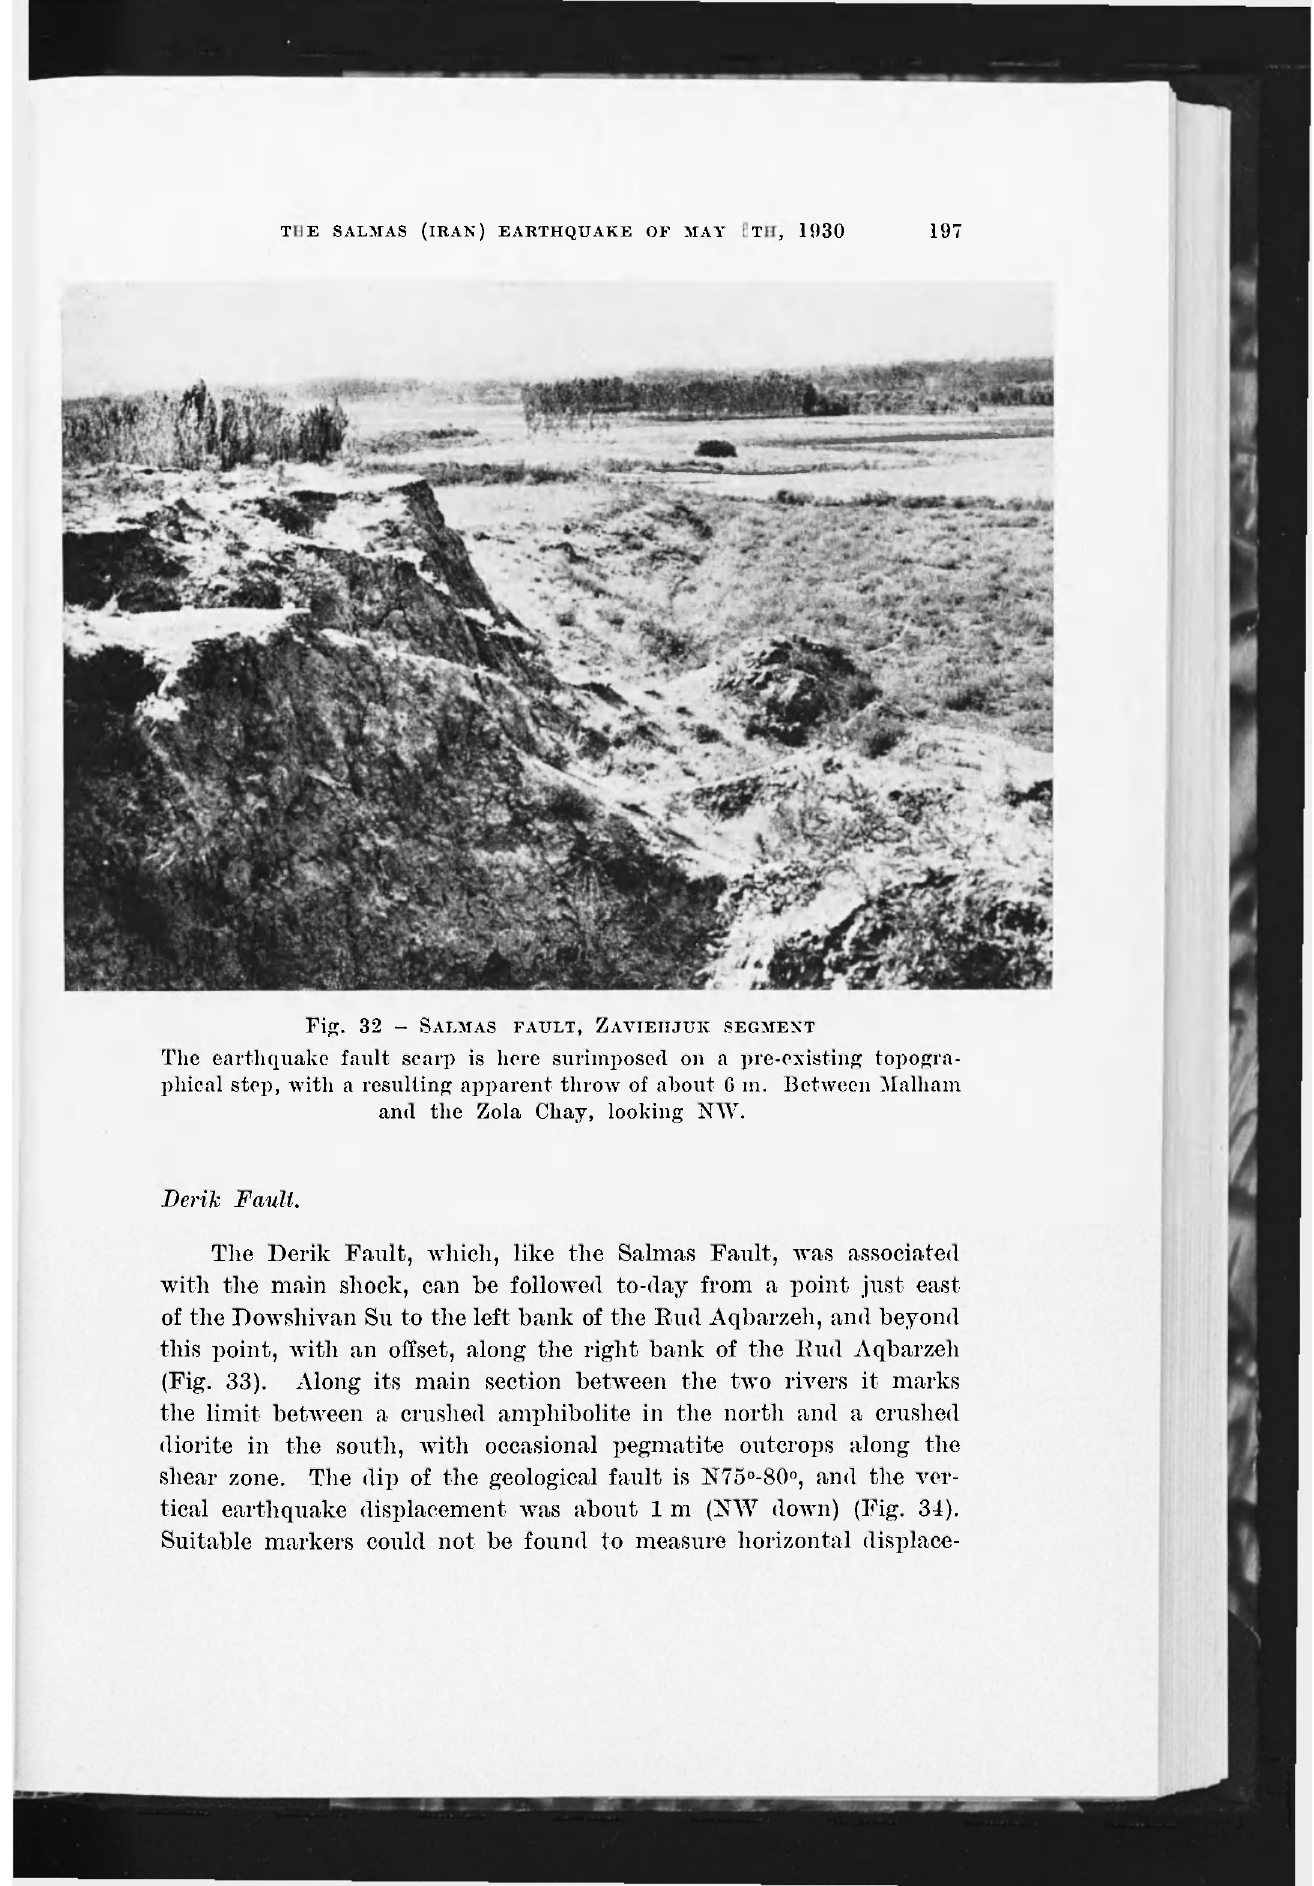
Fig. 32 - SALMAS FAULT, ZAVIEIIJUK